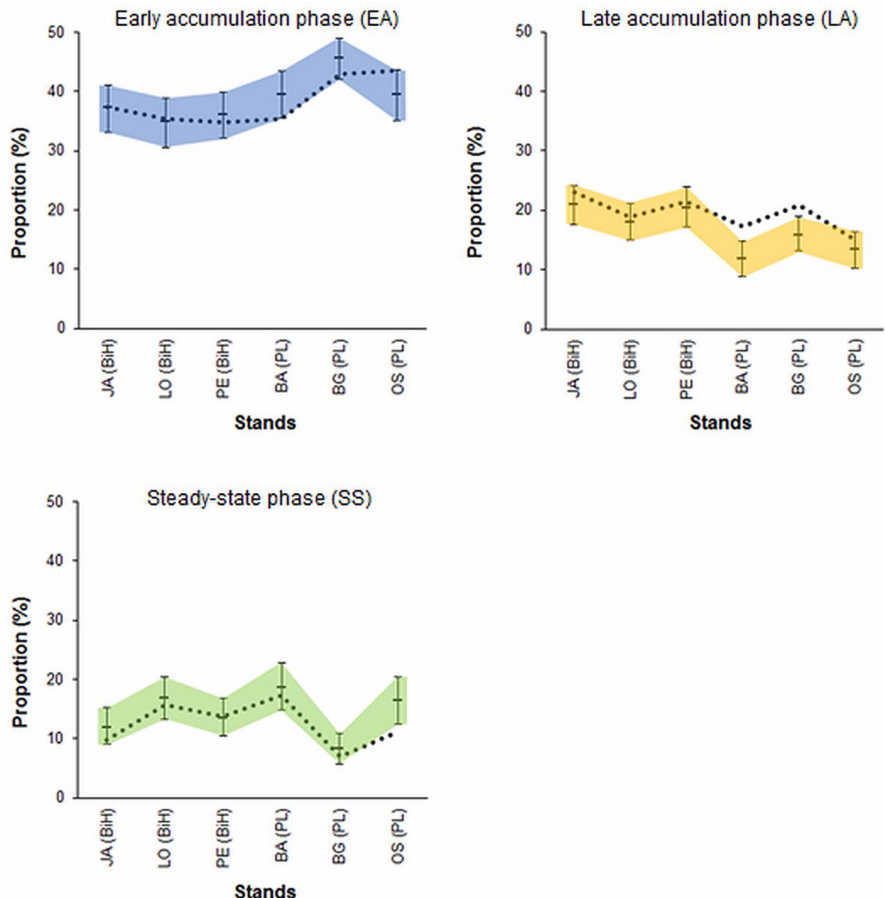
Figure 10. Empirical phase frequencies in six Abies–Fagus–Picea stands (dotted lines) and 95% simulation envelopes for the frequencies obtained from the random assignment of the trees to the sample plots (shaded areas). The empirical values lying above/below the simulation envelopes indicate the over/underrepresentation of a given phase compared to the simulations. The frequency of the culmination phase was not tested because the proportion of this phase is directly linked to the classification